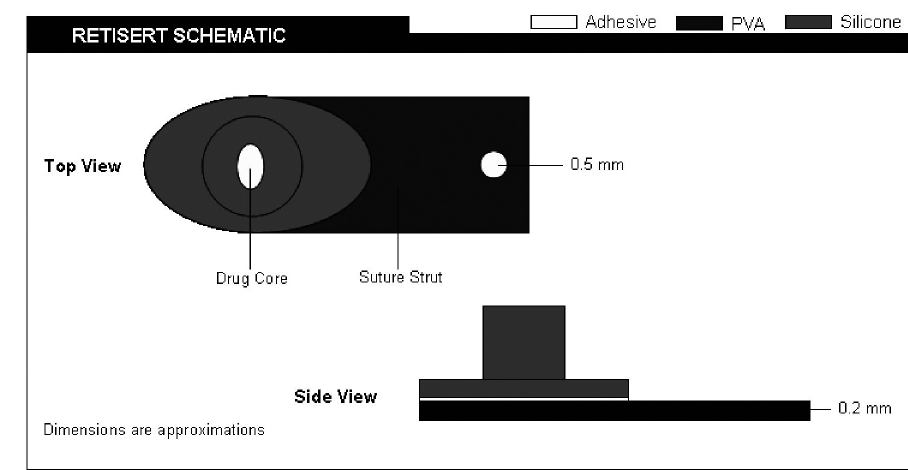
FIGURE 1 - Schematic representation of Retisert ®